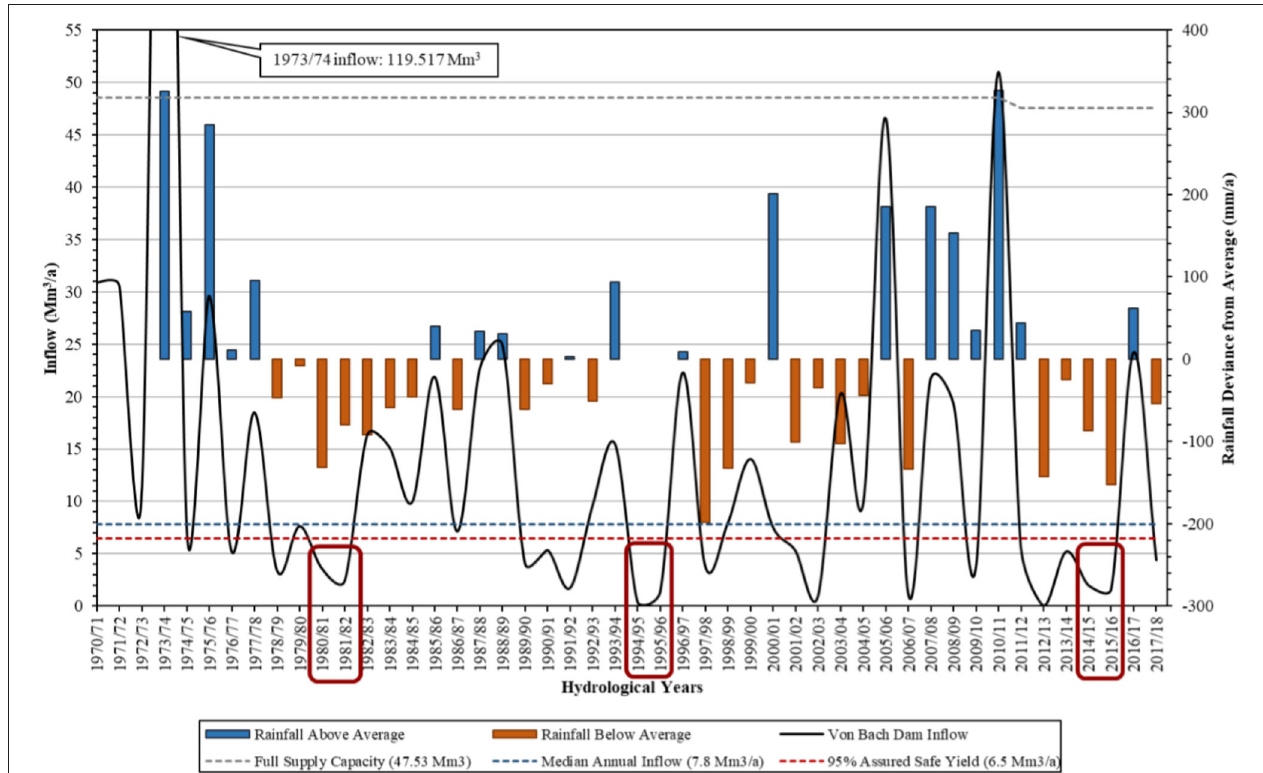
FIGURE 1 | High variability in rainfall and runoff to the Windhoek supply reservoirs, with challenging droughts highlighted. Source: Historical assessment of water resource management and development in Windhoek and the Central Area of Namibia (Bruce and Burger,